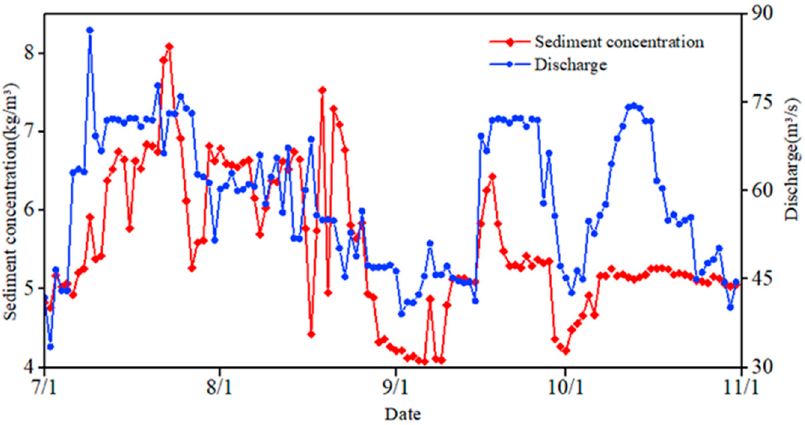
Figure 10. Flow–sediment concentration and sediment concentration variation process in flood season.